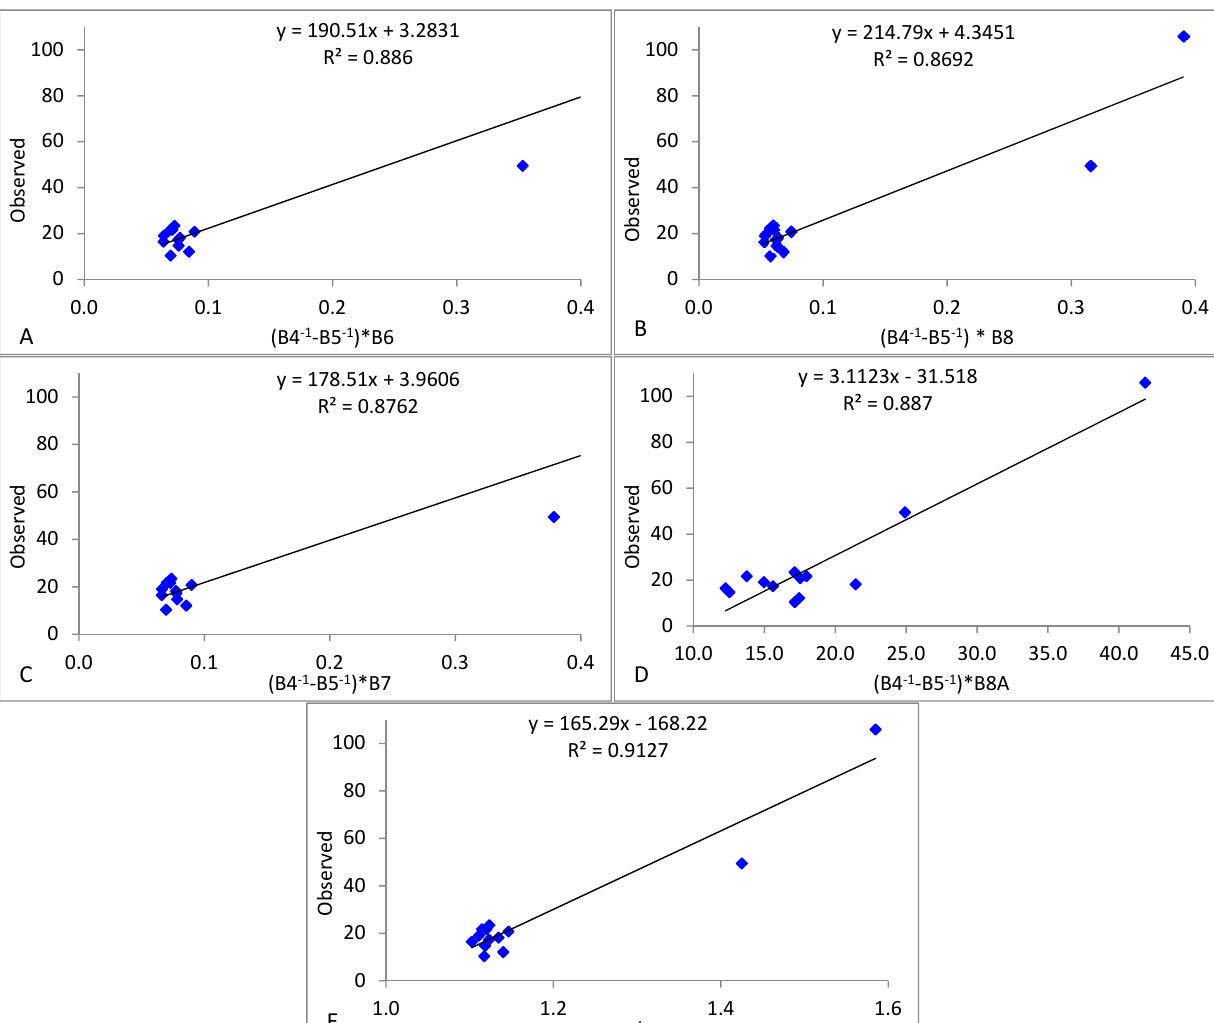
Figure 4. Regression analysis of in situ Chl-a and reflectance corresponding to the S2A band ratios to estimate Chl-a in the reviewed literature (Table 1). Abbreviations of the Sentinel-2 band 1 to band 8a corresponding to B1 to B8a. ( A ) Observed and estimated (band ratio (B4 -1 -B5 -1 ) ∗ B6) Chl-a, ( B ) Observed and estimated (band ratio (B4-1-B5-1) ∗ B8) Chl-a. ( C ) Observed and estimated (band (B4 -1 -B5 -1 ) ∗ B7) Chl-a; ( D ) Observed and estimated (band ratio (B4 -1 -B5 -1 ) ∗ B8A) Chl-a. ( E ) Observed and estimated (band ratio B5/B4) Chl-a.